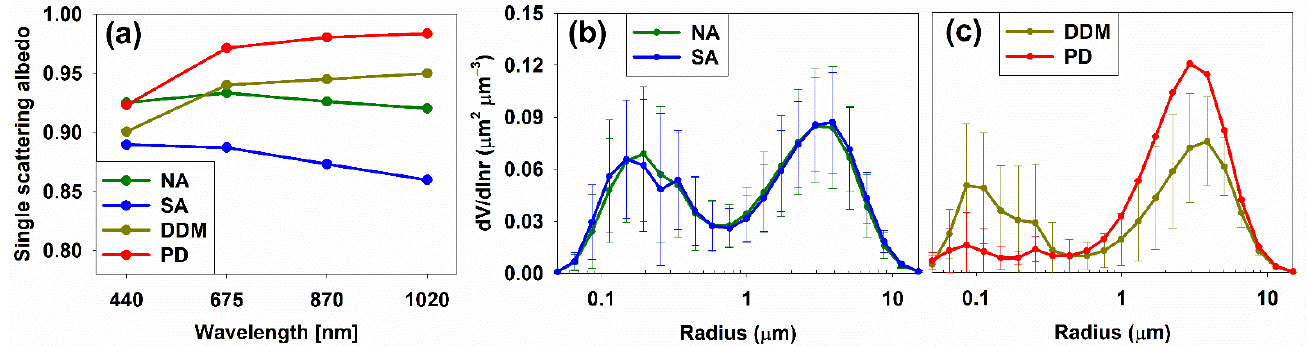
Figure 2. ( a ) Spectral variation in single scattering albedo and mean volume size distributions for ( b ) pollution aerosols (NA and SA) and ( c ) DDM and PD types detected by the RF model. Abbreviations: NA, non-absorbing; SA, strongly absorbing; DDM, dust dominated mixed; PD, pure dust.